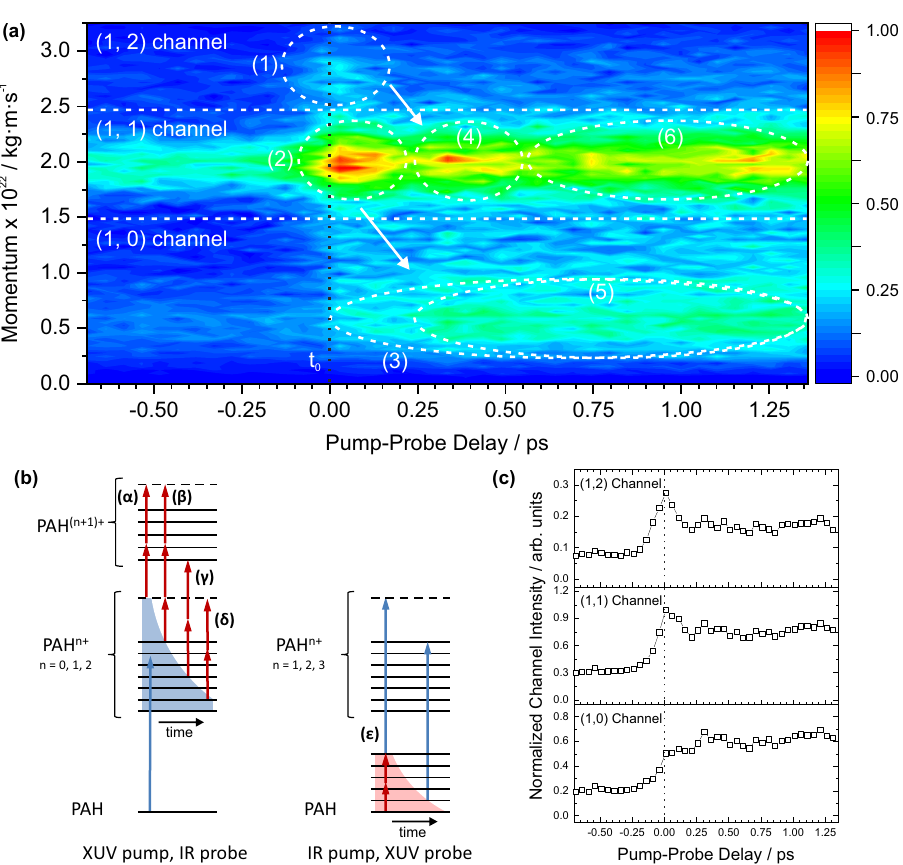
Fig. 4 Time-dependent fragmentation channels. a The C 3 H þ x momentum pro fi le formed from FLU as a function of XUV-IR laser pulse delay. The IR pulse interacting with the molecular beam before the XUV pulse gives negative pump-probe delay values, whereas for positive pump-probe values, the XUV pulse interacts fi rst. The vertical black dotted line indicates t 0 determined by the helium electron sidebands. Channels and numbered features are described in detail in the text. Brie fl y, (1) and (2) show the increase in C 3 H þ x ions formed by dissociative ionization from the PAH 3 + and PAH 2 + ion, respectively, around t 0 . (3) shows the increase in C 3 H þ x ion signal after t 0 due to the XUV pulse creating PAH + ions that are dissociated by the IR pulse. (4) and (5) show the increase in signal in the (1, 1) and (1, 0) channels following relaxation of the PAH 2 + and PAH + ions, respectively, and dissociation by the IR laser pulse. (6) highlights the general increase in signal after t 0 compared to before t 0 , even after a long pump-probe delay, in this case, due to the XUV pulse creating PAH 2 + ions which are dissociated by the IR pulse. White arrows highlight the shift in channel yields from pathway β and γ to pathway δ , as denoted in ( b ). b Schematic of the PAH states involved in this experiment. Solid black lines and dashed lines represent bound and dissociative electronic states, respectively. Blue and red arrows represent the effects of the XUV laser and IR laser pulses, respectively. The pump pulses are able to populate a multitude of electronic states, as represented by the blue and red shaded areas for the XUV and IR pulses, respectively. Electronic relaxation of the wavepacket over time is represented by the curvature in the shaded areas. The change in electronic states due to relaxation alters the product of the probe pulse. c Integrated plots of the (1, 0), (1, 1), and (1, 2) channels from ( a ). Plots are normalized to the maximum signal detected in the (1, 1) channel, and t 0 is represented by the dotted black